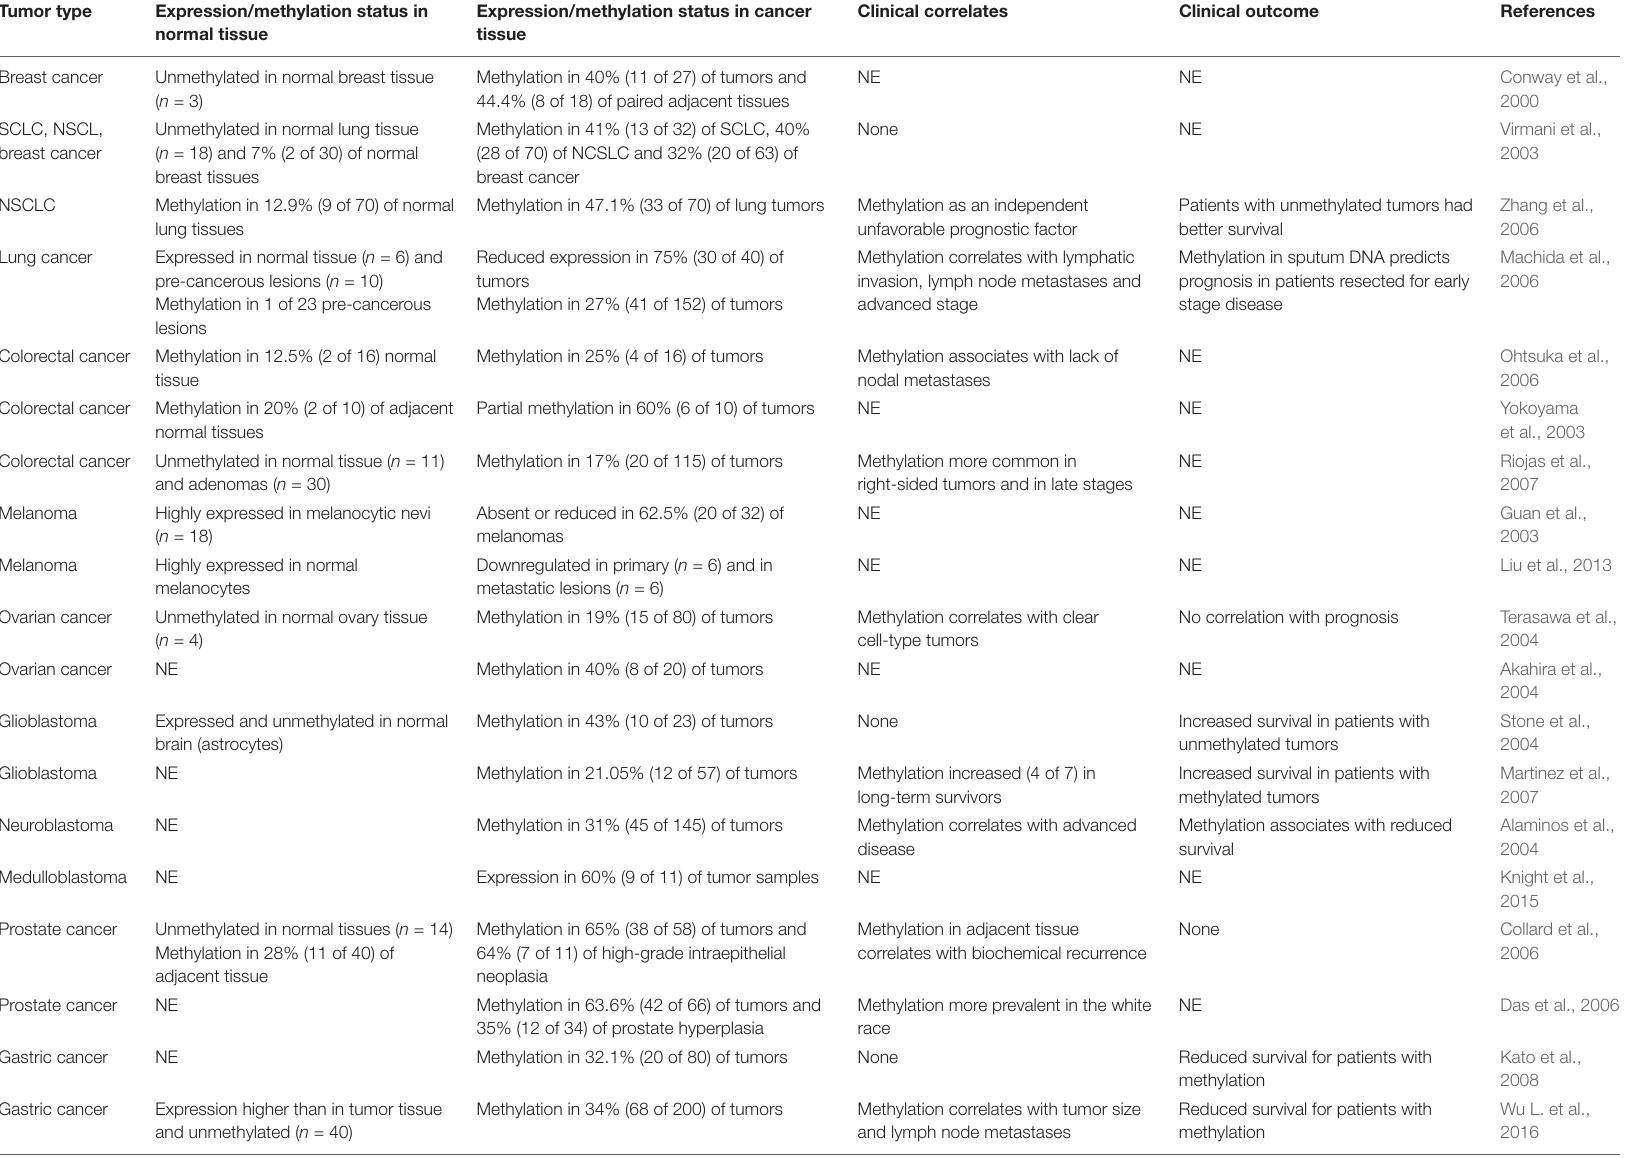
TABLE 1 | ASC/TSM1 up- and down-regulation (methylation status) and clinical correlates in human